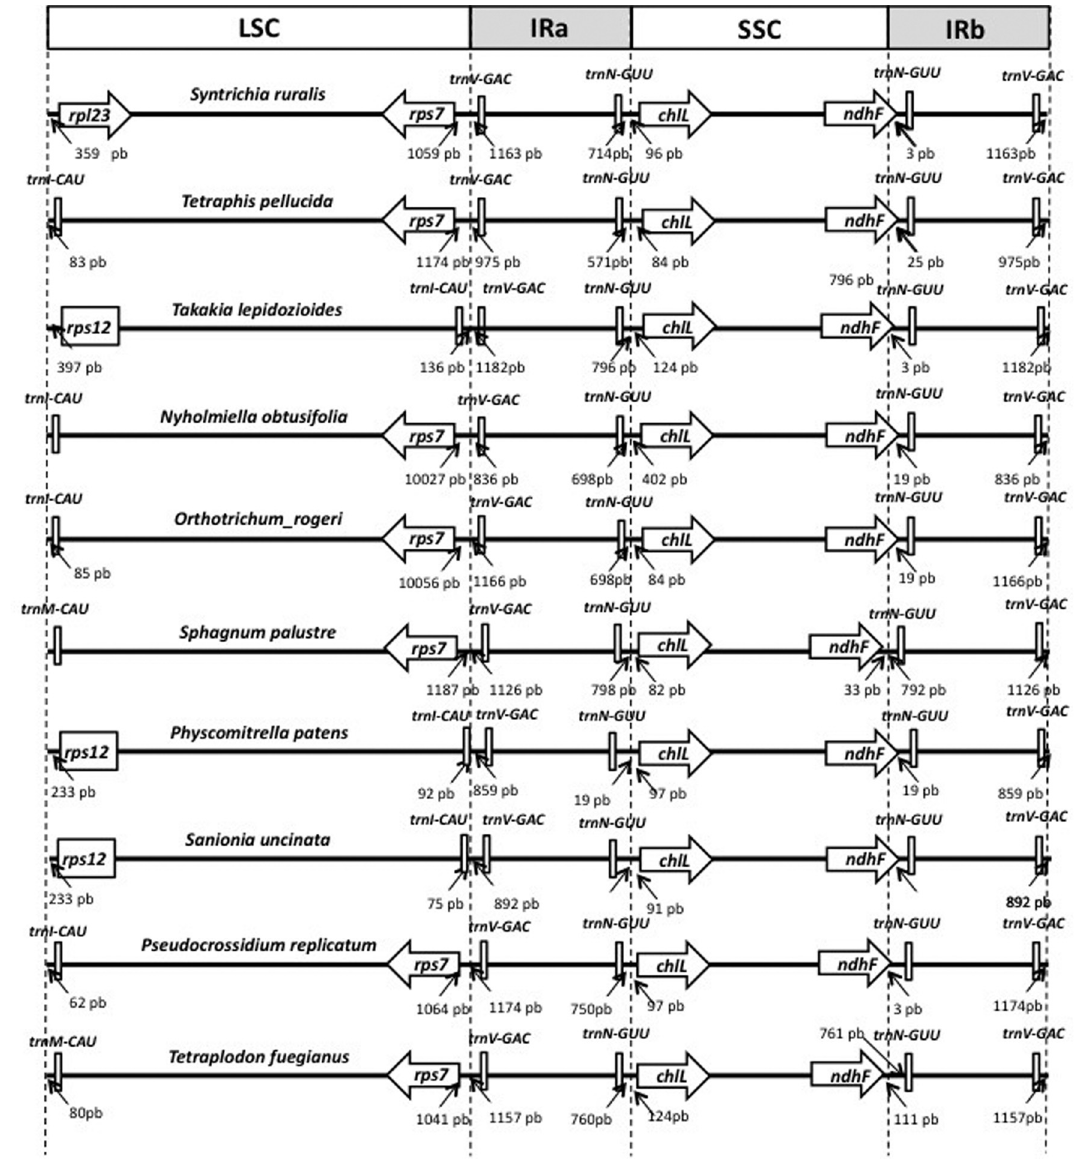
Figure 3 - Comparison of chloroplast genome structure between mosses. Shown are the genome distances and gene position in the vicinity of LSC, IRB, SSC, and IRA in the genome structure of mosses